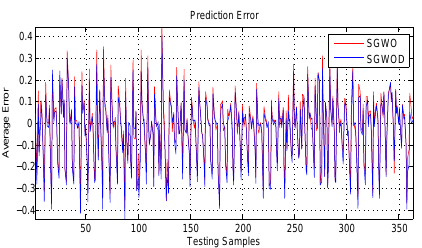
Figure 11. The prediction error of the